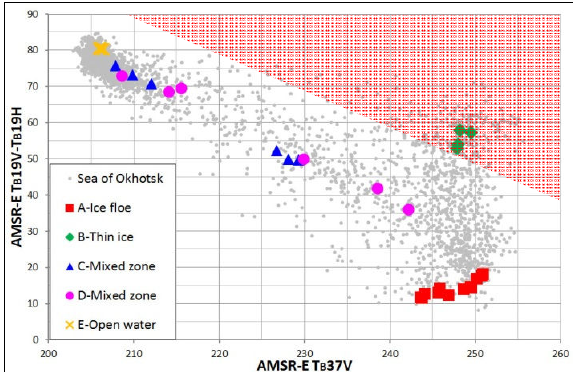
Fig.11 Scatter plots of T B ( 19GHzV-19GHzH ) versus T B ( 37GHzV ) Fig.12 Thin ice area extraction